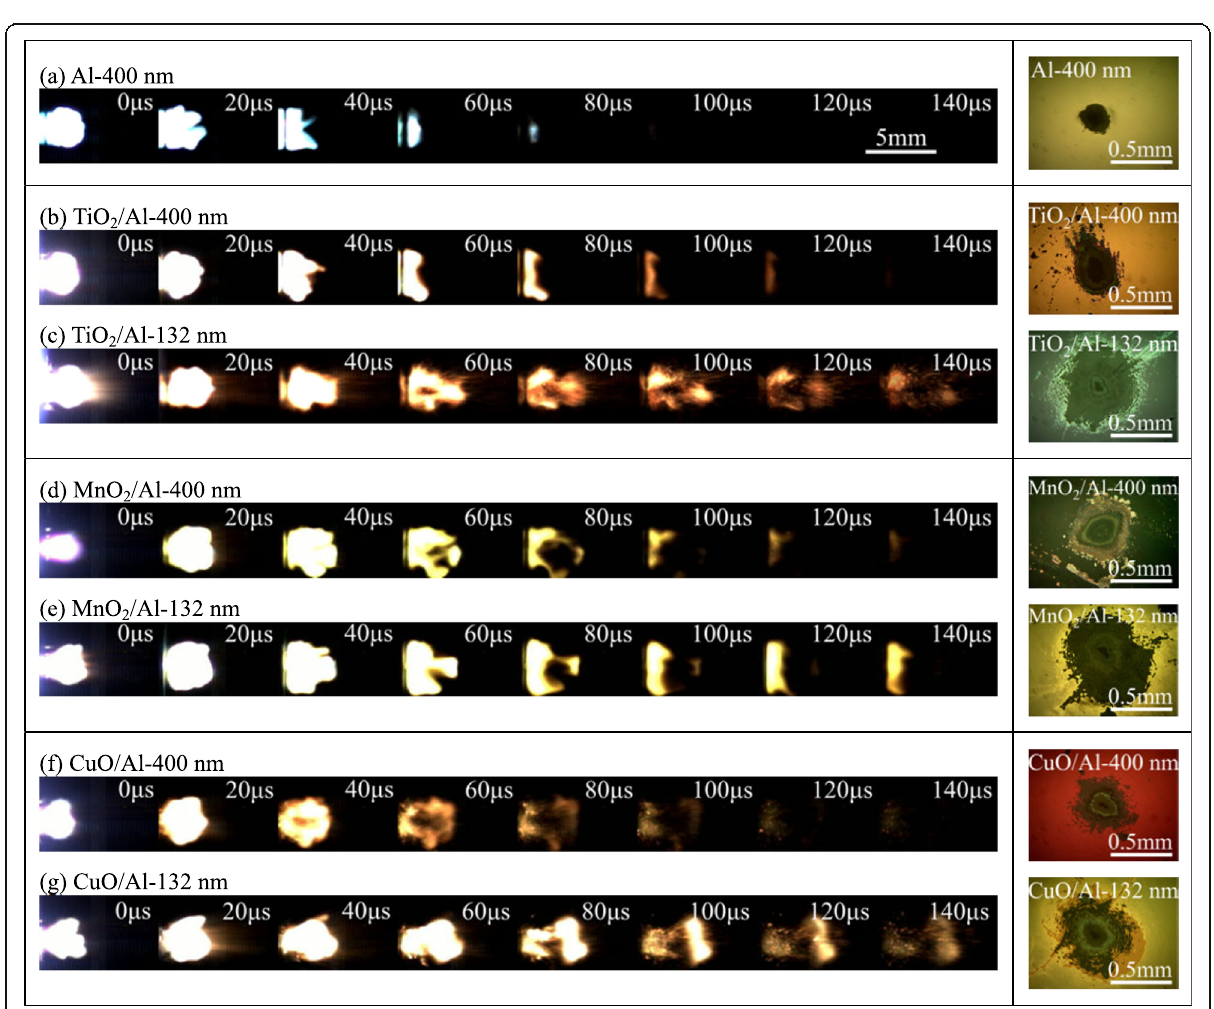
Fig. 5 Laser-induced processes of the single-layer Al film and various RMFs and their microscope images after ignition. a Al-400 nm. b TiO 2 /Al- 400 nm. c TiO 2 /Al-132 nm. d MnO 2 /Al-400 nm. e MnO 2 /Al-132nm. f CuO/Al-400 nm. g CuO/Al-132